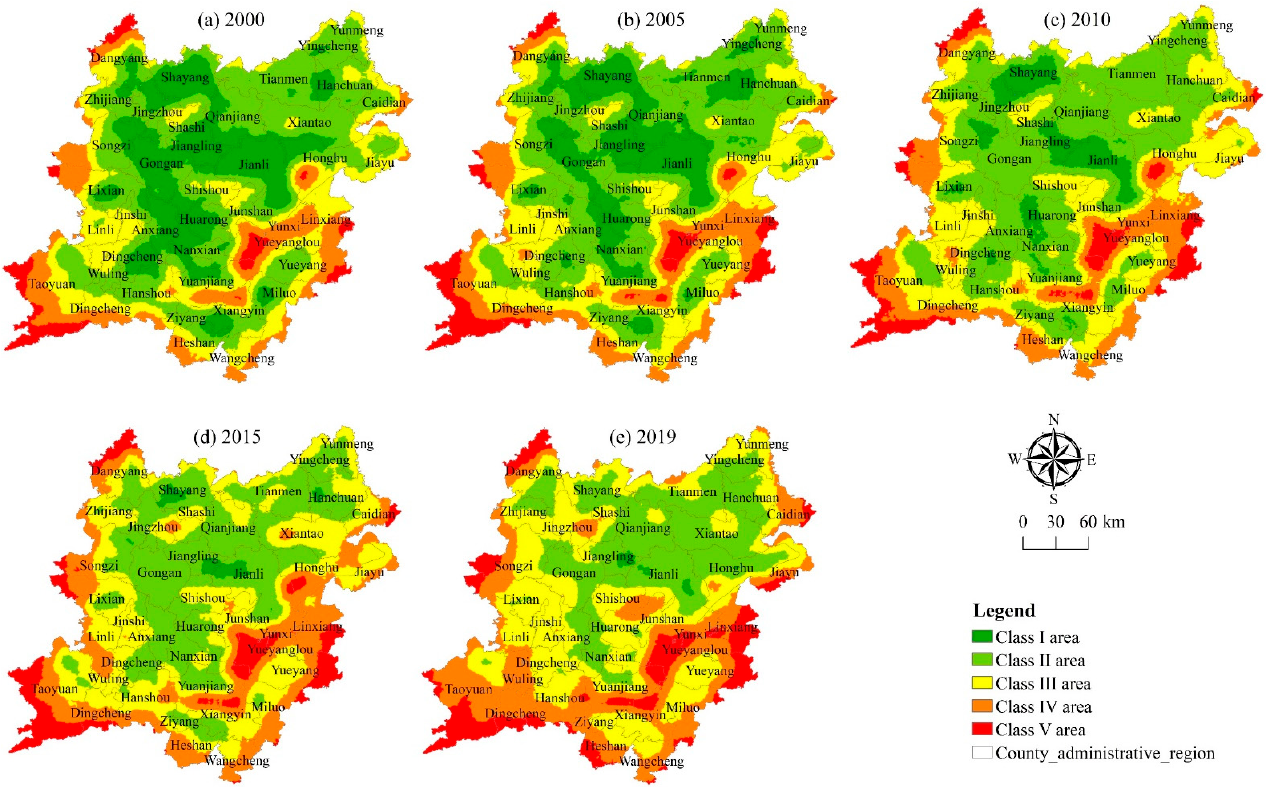
Figure 8. Spatial distribution of cultivated land system health in the two lake plains from 2000 to 2019.